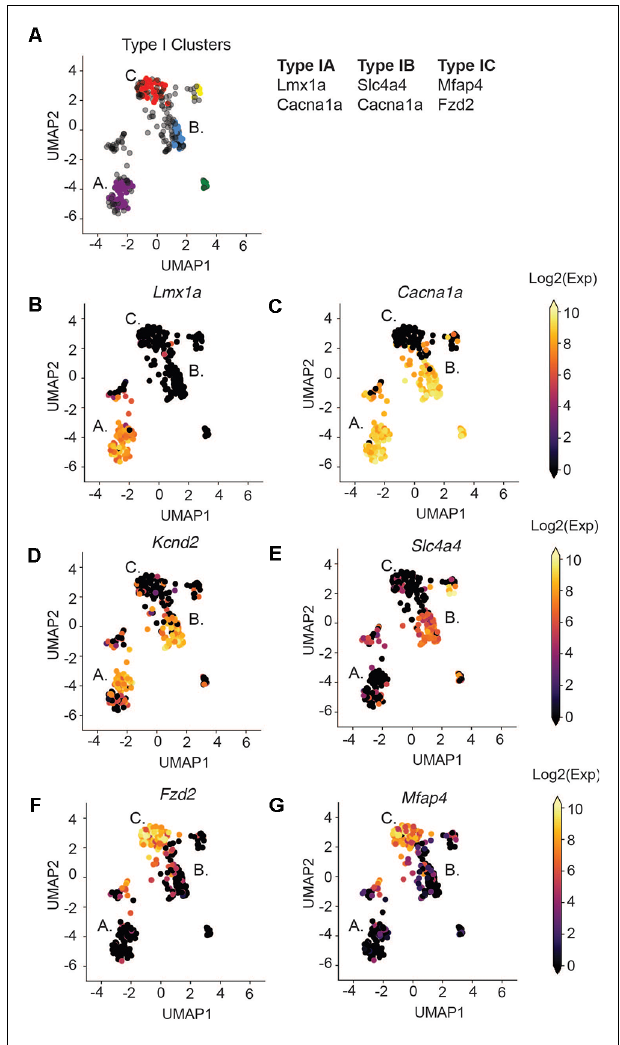
FIGURE 3 | Type I SGNs cluster into three subtypes. (A) UMAP projection of the Type SGNs at postnatal day 8. Each point represents a cell. Cells clustering to Type IA, IB, IC are colored in purple, blue, and red, respectively. The major gene markers for each subtype are given on the right. Two additional clusters were found (in yellow and green) but are not considered in this analysis as they did not have clear marker genes. Cells in gray were not clustered into any of the subgroups. (B–G) UMAP projection of Type I cells. Each cell is colored by the expression of (B) Lmx1a , (C) Cacna1a , (D) Kcnd2 , (E) Slc4a4 , (F) Fzd2 , (G) Mfap4 . The expression scale is given on the